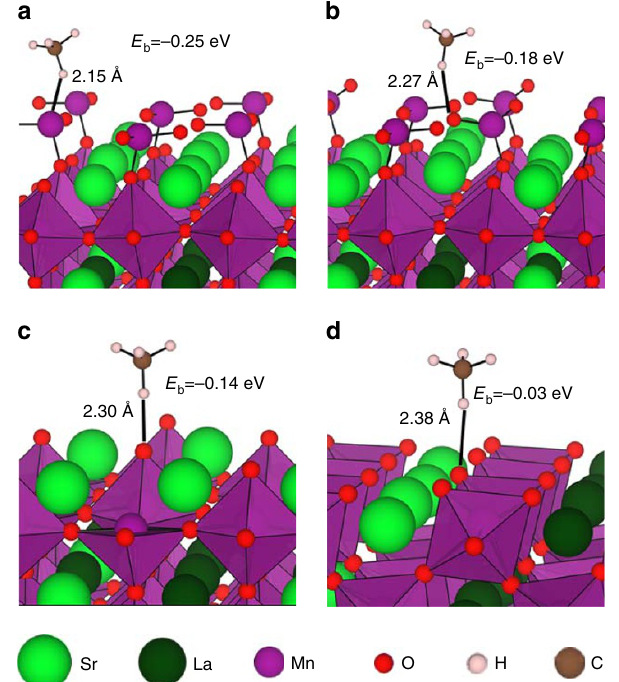
Figure 5 | DFT analysis. Stable adsorbed CH 4 configurations on the (001) and (110) surfaces: ( a ) CH 4 adsorbed on Mn and ( b ) on O on the (001) MnO 2 -terminated surface, ( c ) CH 4 adsorbed on O on the (001) SrO- terminated surface and ( d ) the (110)